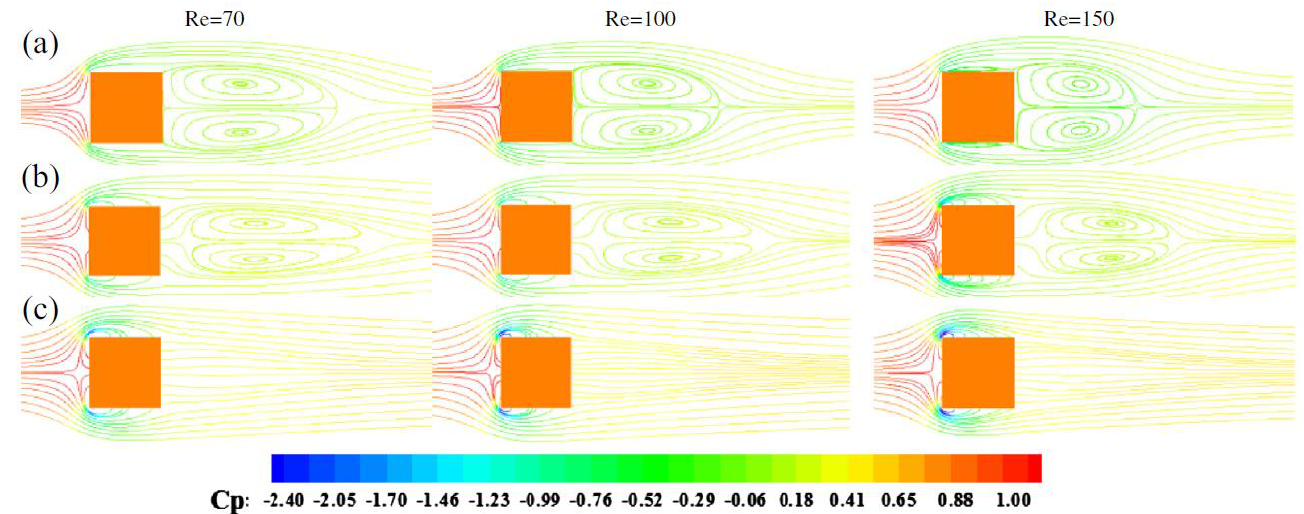
Figure 1. Time-averaged streamlines colored by the pressure coefficient for a different suction/blowing parameter and Reynolds number for the case ( a ) without a control (| Γ | = 0), ( b ) with a control (| Γ | = 0.05) and ( c ) with a control (| Γ | = 0.15) (figure reprinted from Sohankar and Khodadadi [18] Copyright (2015), with permission from Elsevier).